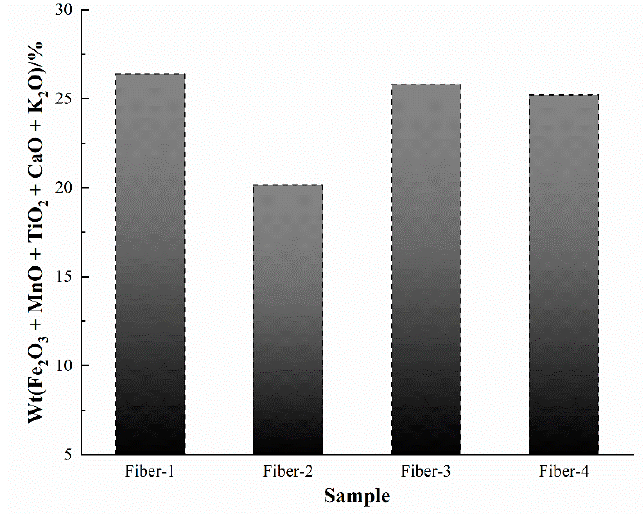
Figure 5. Wt (Fe 2 O 3 + MnO + TiO 2 + CaO + K 2 O) of different fibers.